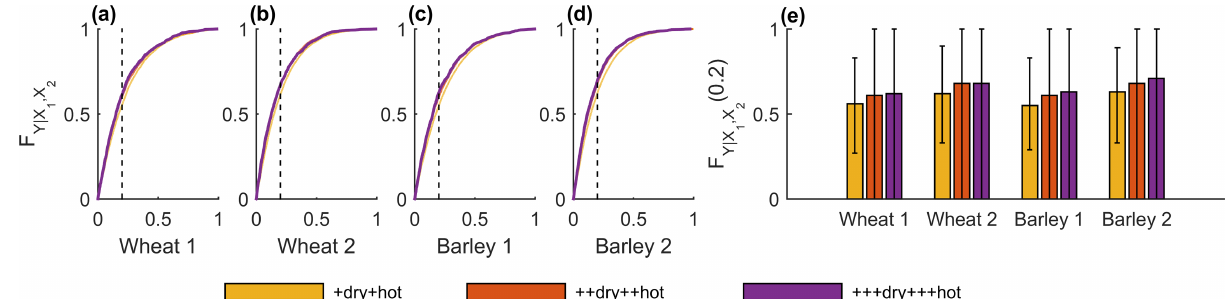
Figure 6. Conditional probability distributions of crop yield anomalies F Y | X wheat in Region 2 b , barley in Region 1 c and barley in Region 2 d ) under moderate (+dry+hot, yellow), severe (++dry++hot, orange) and extreme (+++dry+++hot, purple) compound dry and hot conditions (see Table 1). (e) Conditional probabilities of not exceeding the crop loss threshold (20th percentile – vertical dashed line in a–d ) for each severity level of compound dry and hot conditions given by F Y | X Uncertainty ranges illustrate the 95% confidence